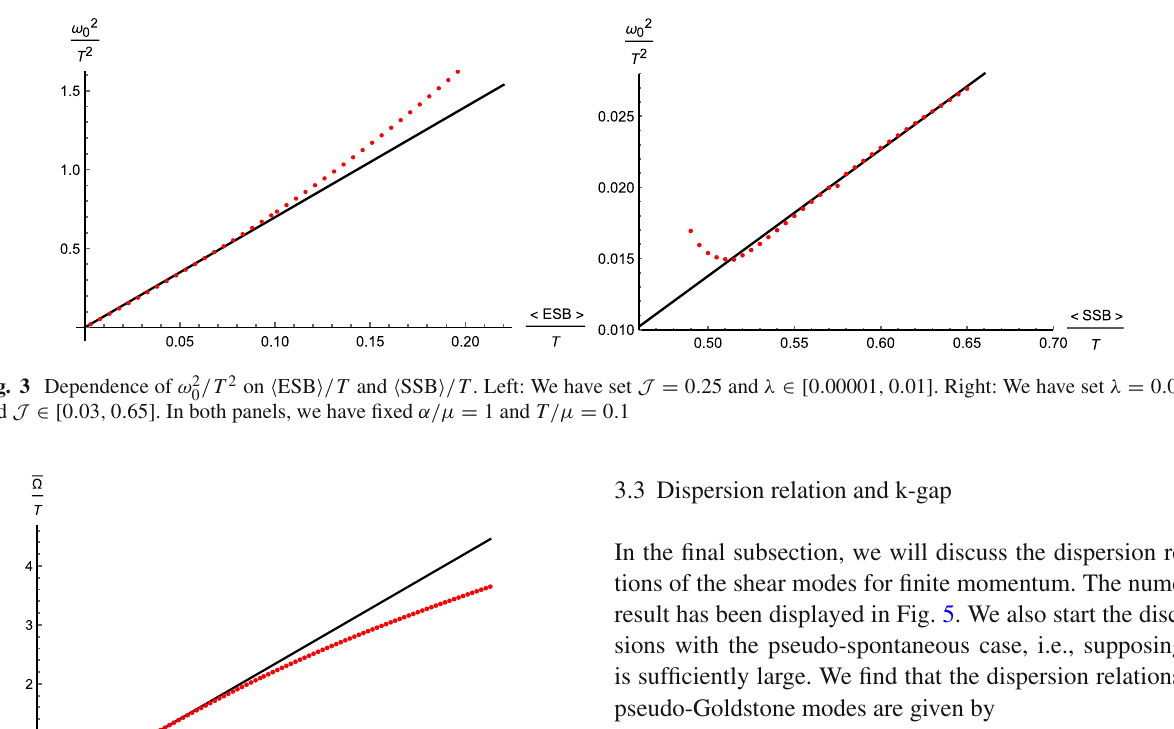
function of 1 /β ≡ (λ/ J ) 1 2 where the red dots are the numeric data extracted from QNMs and the solid line is the fitting result. Here, we fix T /μ = 0 . 1. When β (cid:14) 1, the collision always happens in the hydrodynamic regime, i.e., | ω coll | (cid:16) T